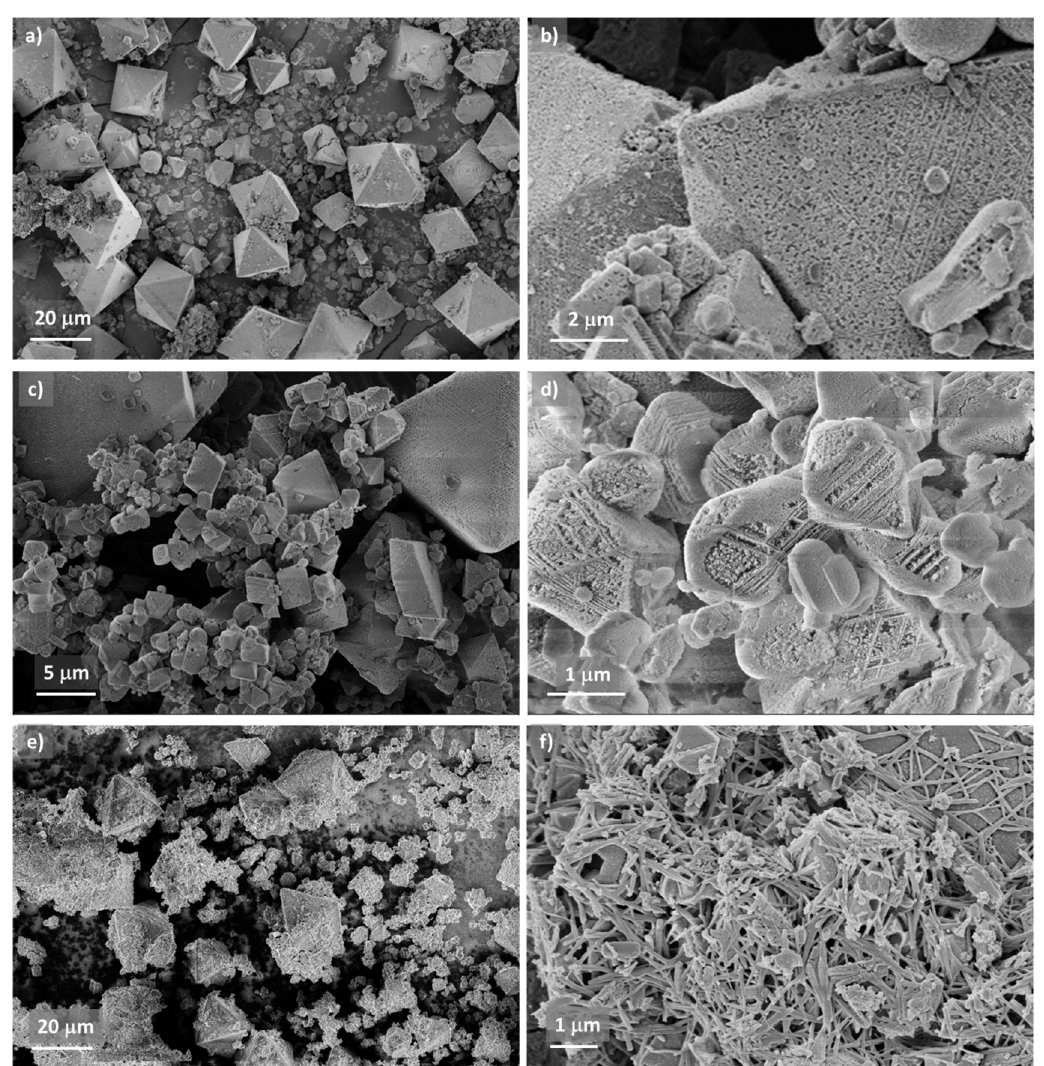
Figure 3. Morphology of H1 ( a , b ), Ce@H1(W) ( c , d ), and Ce@H1(D) ( e , f ).